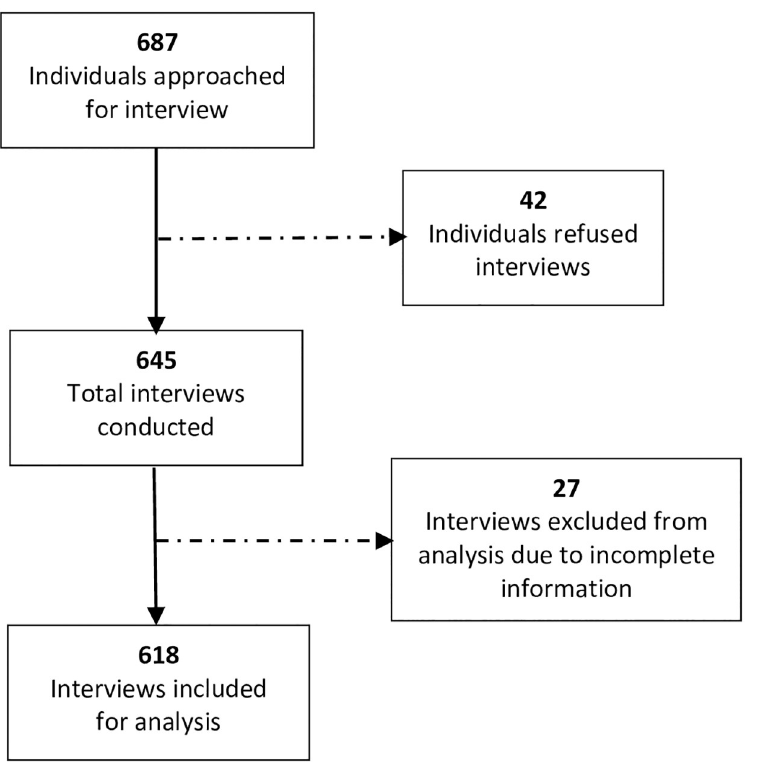
Fig 1. Flowchart of the sampling design and subject enrolment in the